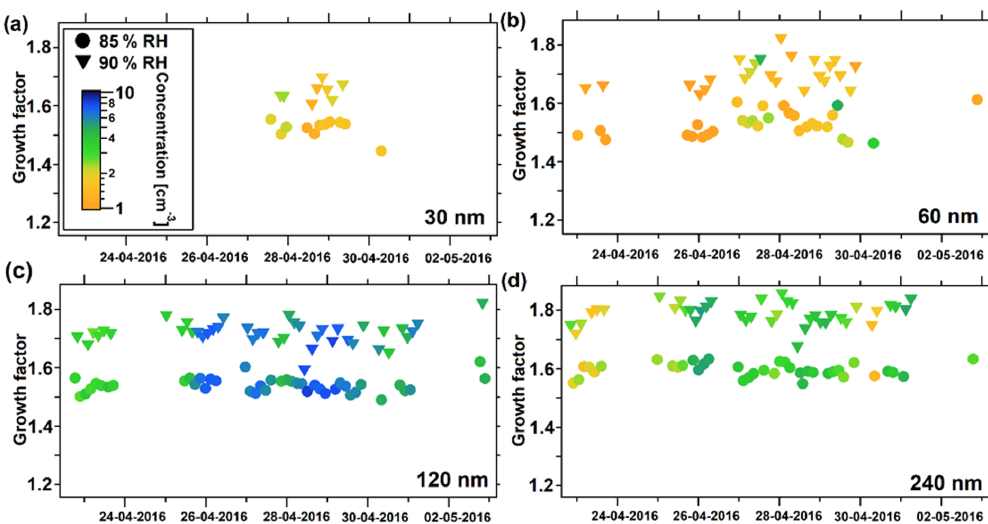
Figure 7. Particle hygroscopic growth factors during the spring study. (a) Growth factors at 30nm Dp dry , (b) at 60nm Dp dry , (c) at 120nm Dp dry , and (d) at 240nm Dp dry . Dots represent values at 85% RH and triangles at 90% RH. The color indicates the raw parti- cle number concentration measured at that certain Dp dry , downstream of the first and upstream of the second DMA.